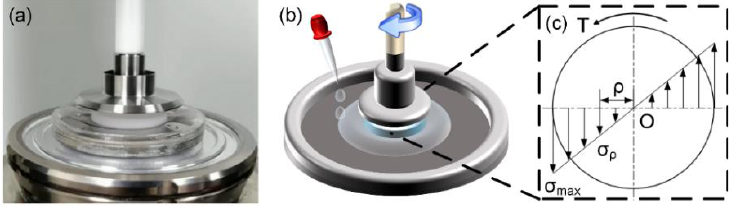
Figure 3. Schematics of the friction test and shear stress distribution. ( a ) The friction test device. ( b ) The schematic of the friction test device. ( c ) Frictional stress distribution. ρ, radial distance; σ ρ , frictional stress at a radial distance of ρ; σ max , maximum frictional stress; T, friction torque.